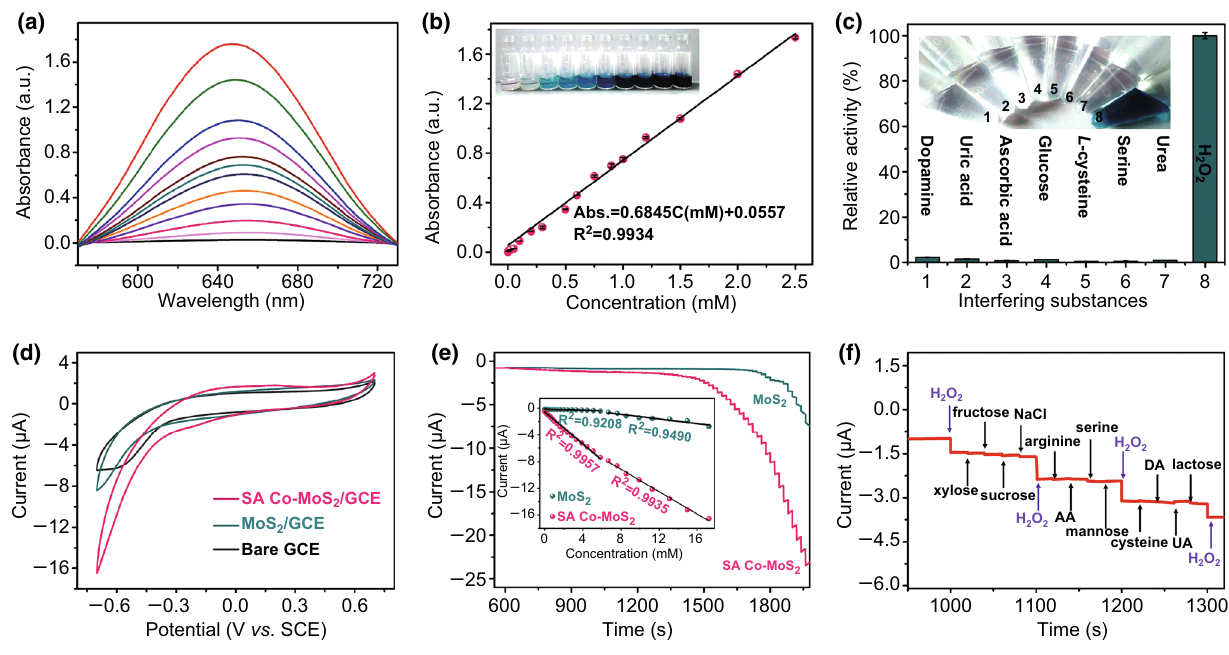
Fig. 5 a Changes in the UV–Vis absorbance spectra in the presence of different concentrations of H 2 O 2 . b The corresponding linear calibration plots. c The selectivity of the SA Co–MoS 2 peroxidase‑like catalytic activity. d CV responses of SA Co–MoS 2 /GCE, MoS 2 /GCE, and bare GCE in the presence of 0.1 mM H 2 O 2 in 0.01 M PBS (pH = 7.4). e Amperometric response recorded at the MoS 2 /GCE and SA Co–MoS 2 /GCE after the successive addition of